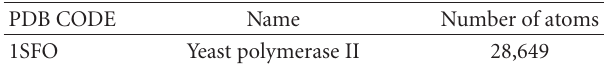
Table 4: Selected molecular